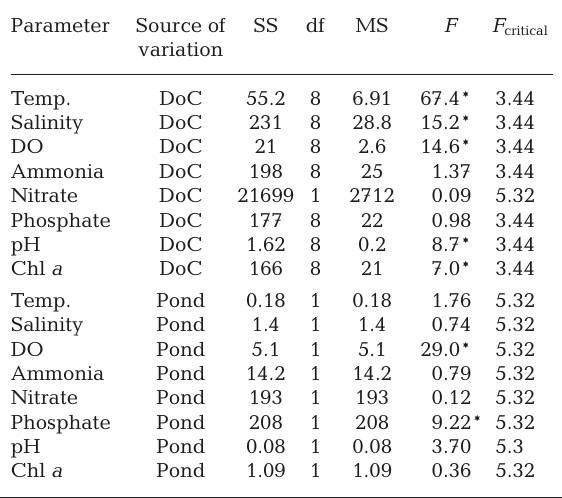
Table 1. ANOVA of water quality parameters between days of culture (DoC) and between the 2 ponds. DO: dissolved oxygen. *p <